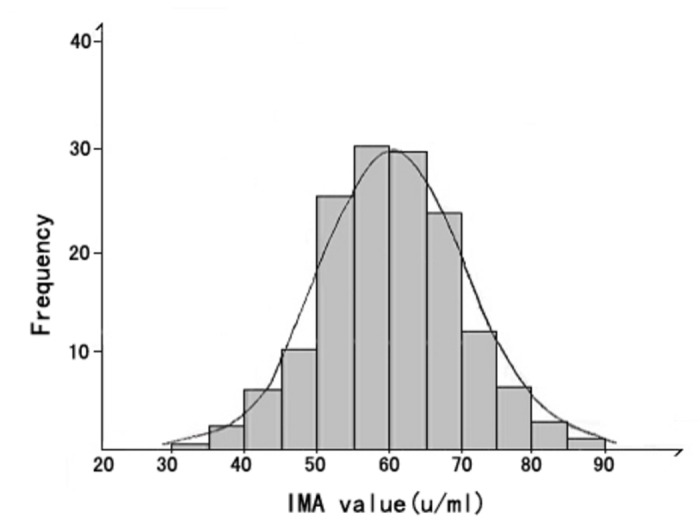
The distribution of serum IMA concentration data from pre-chemotherapy.The distribution of serum IMA concentration data from pre-chemotherapy is normal. The mean IMA concentration was (59.2 ± SD 10.9) U/ml.